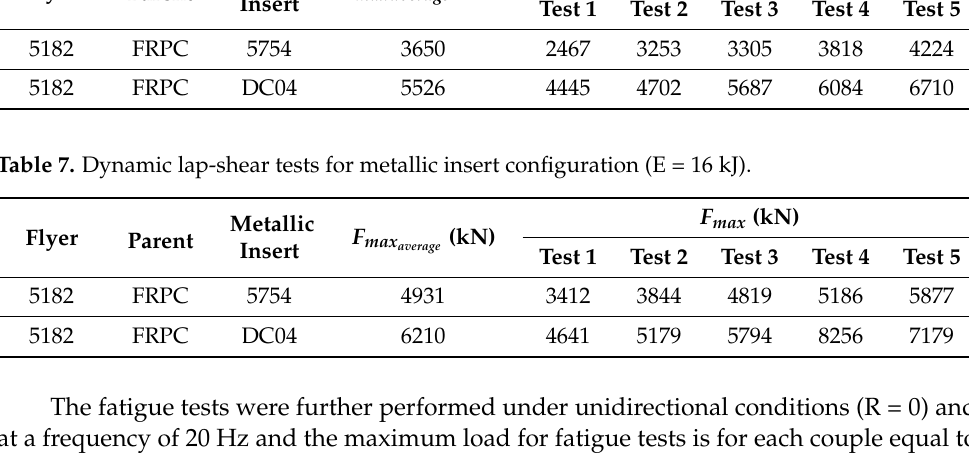
Figure 12. Failure during fatigue test of the joining between the 5182 and aluminum 5754 insert (E = 16 kJ). 3.1.2. Configuration with DC04 Steel Metallic Insert As mentioned earlier, here the flyer is aluminum 5182 and the insert embedded into the composite is a perforated flanged sheet of steel (DC04). Herein, the flanged design was preferred, as mentioned earlier, for the aluminum insert, as it produced better results.